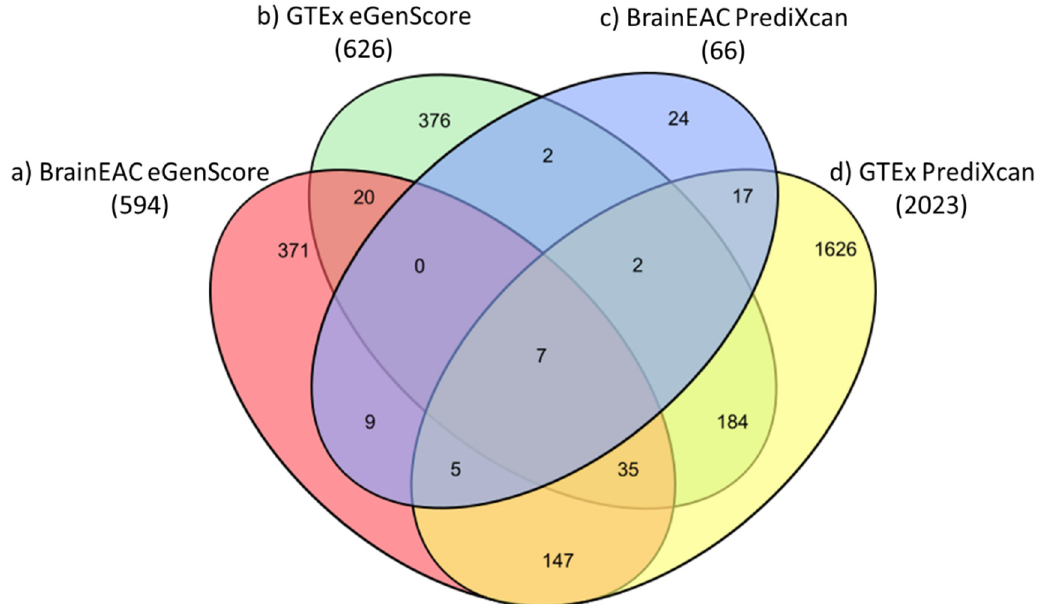
Figure 3. Venn diagram representing the number of genes for which an eQTL model trained with (a) BrainEAC and eGenScore (orange); (b) GTEx and eGenScore (green); (c) BrainEAC and PrediXcan (blue); or (d) GTEx and PrediXcan (yellow) was found to be statistically significant during the internal validation (i.e., | r avg | > 0.1 and Fisher’s p -value < 0.05).